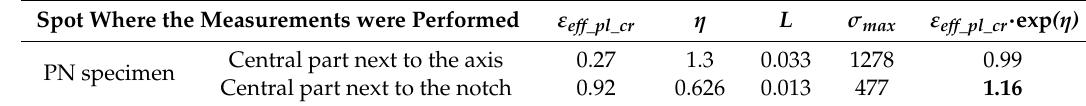
Figure 7. Distribution of η , L , ε eff_pl functions. ( a ) Curves drawn along the longer specimen axis, specimen PN, material HW, temperature +20 °C, last step of the integration. ( b ) Curves drawn along the notch, specimen PN, material HW, temperature +20 °C, last step of the integration. ( c ) Curves drawn along the shorter specimen axis, specimen PN, material HW, temperature +20 °C, last step of the integration. ( d ) Maximum opening stress along the longer stress distribution and along the notch, specimen PN, material HW, temperature +20 °C, last step of the integration. Table 3. Values of the mechanical field parameters at the critical moment along the PN specimen fracture surface. Material N. Temperature +20 °C.